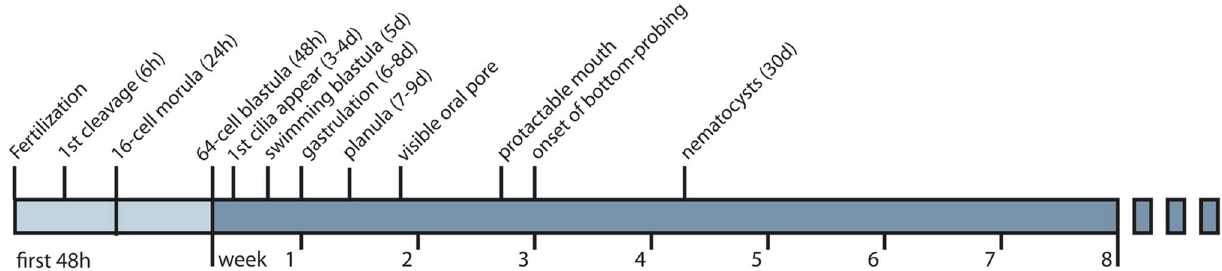
Figure 5. Timeline for the embryonic and larval development. Embryos reached the 64-cell blastula stage after 48 h. First cilia appeared day 3, and embryos were swimming blastulae day 5. During gastrulation (day 6–8) embryos were mainly still, rotating slowly around the oral-aboral axis, and resumed swimming after gastrulation was completed. An oral pore became visible when larvae were c. 2 weeks old, and the mouth became protractable and adjustable at c. 20 days. Bottom probing behavior was first observed when larvae were 3 weeks old and peaked at 4–5 weeks. Nematocysts appeared when larvae were 30 days old and if nematocysts are used for primary anchoring, this could indicate that larvae are competent to settle at this time. Larval longevity was c. 8 weeks, the longest lived larvae being 57 days old.